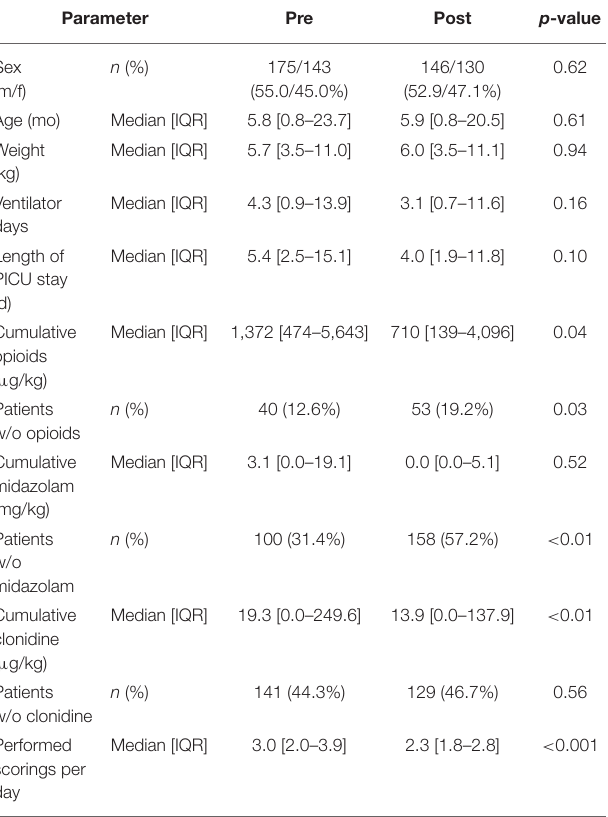
TABLE 3 | Differences of patients’ characteristics between the pre-implementation group and post-implementation group in patients aged 60 months and younger. Parameter Pre Post